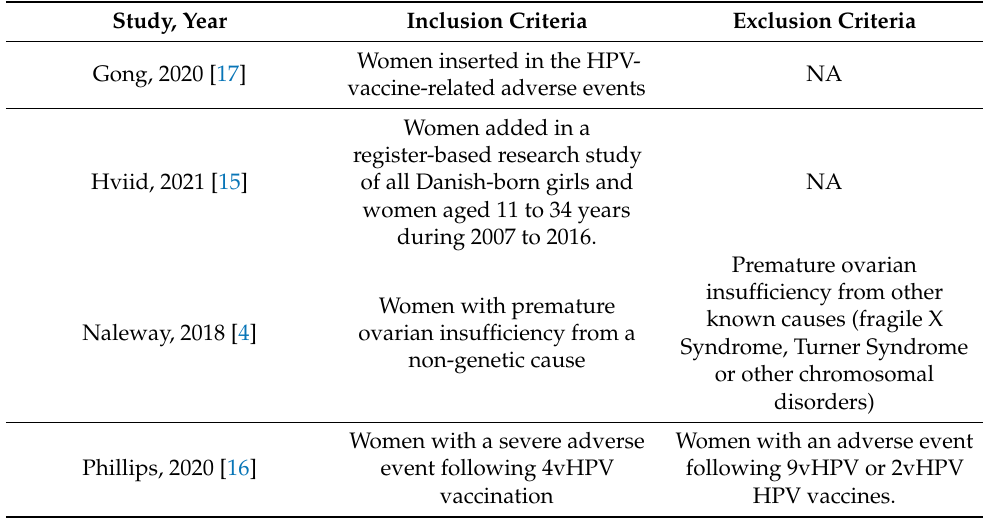
Table 2. Inclusion and exclusion criteria for included